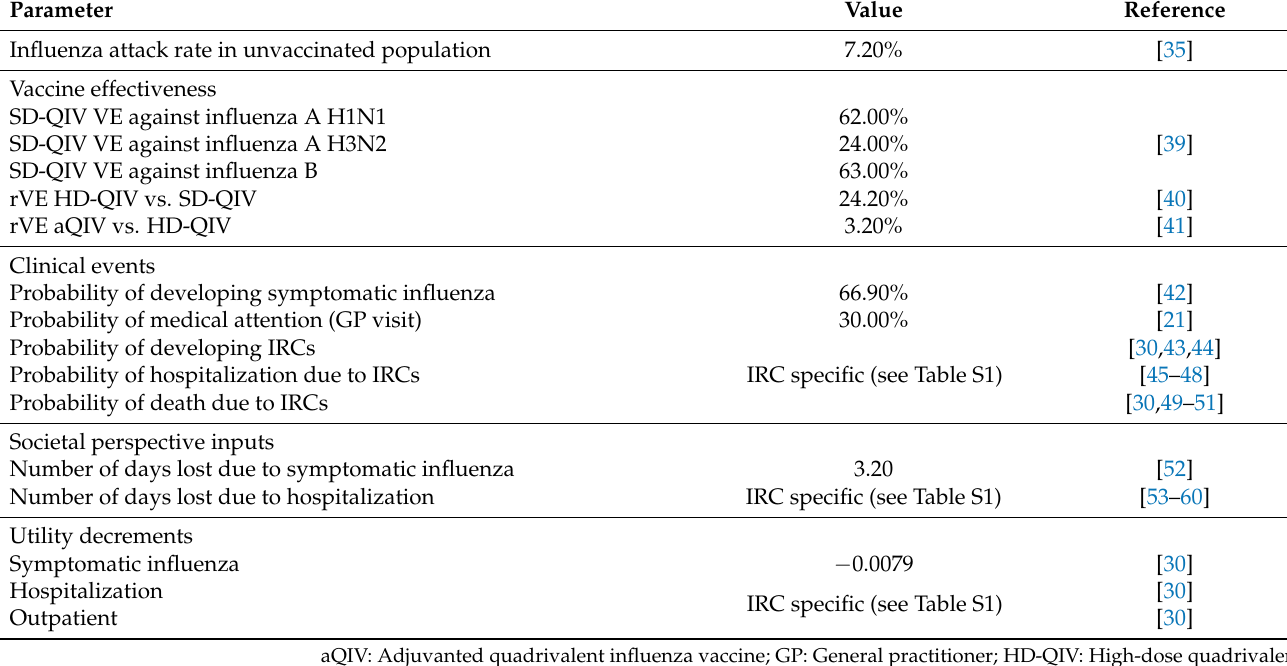
Table 1. Model inputs applied across all